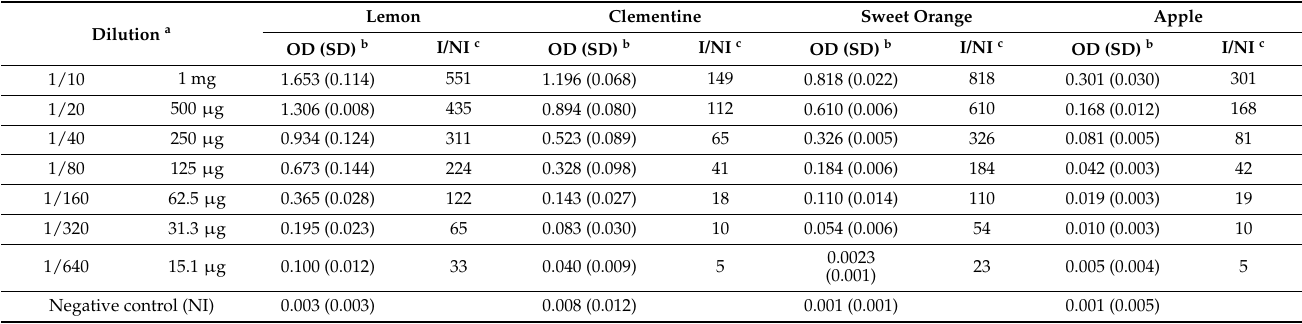
Table 3. Sensitivity of the DAS-ELISA test in different citrus species and apple using the antiserum against NP protein of